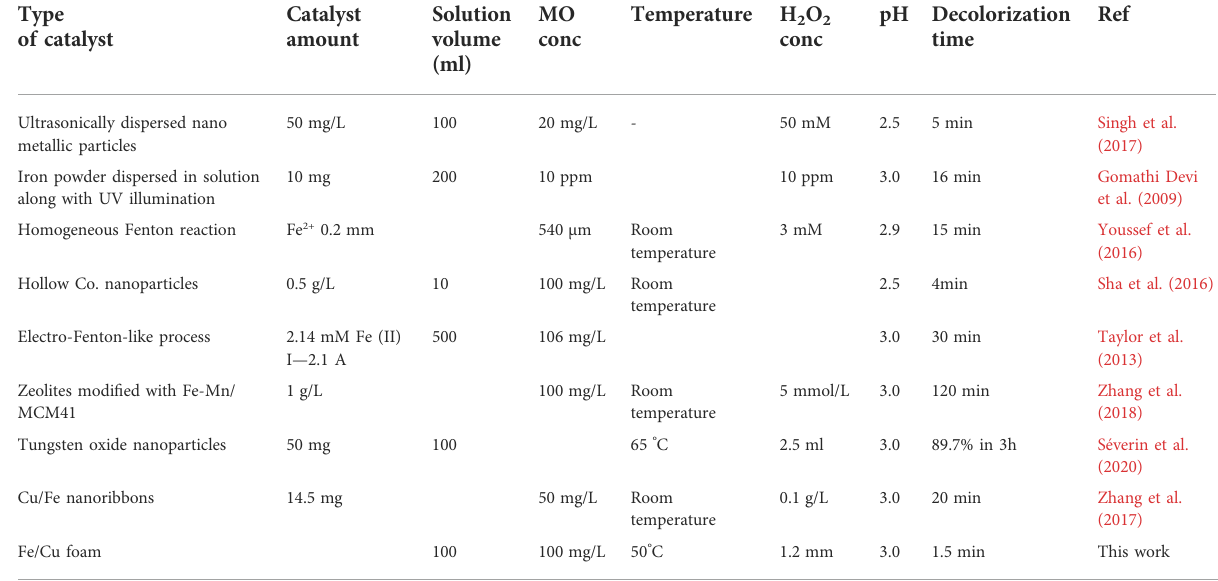
TABLE 1 Comparison of various Fenton catalysts for the degradation of